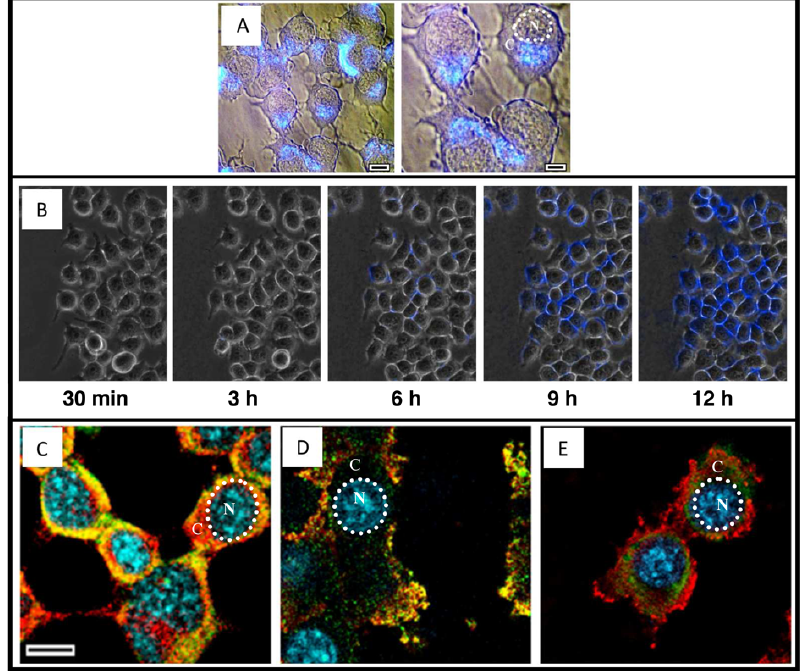
Figure 1. A b 1–42 oligomer distribution in N2a cells. A) High magnified, fluorescence microscopy pictures showing the cellular localization of fluorescent dye 6 hours after 30 m M A b 1–42-EDANS large oligomers incubation. The fluorescence is mainly confined to the cytoplasm [C] and did not penetrate into the nucleus [N]. Scale bar 10 and 5 m m. B). The kinetic of accumulation was carried out by time lapse recording experiments coupled to fluorescence microscope acquisition (40 6 of magnification). Each single image represents the merge between the contrast phase signal and the fluorescence of the field excited in the UV range (from 380 to 425 nm of wavelength), Scale bar 40 m m. C-D-E) N2a cells were treated with 30 m M A b 1–42 large oligomers for 6 hours prior to immunocytochemistry analysis. C) vimentin, D) GRP-78 and E) cathepsin D (all FITC) plus A b 6E10 staining (TRIC 546); nuclei were stained with Hoechst 33285. Scale bar. 15 m m. Images were merged by superimposing single fluorescence images.